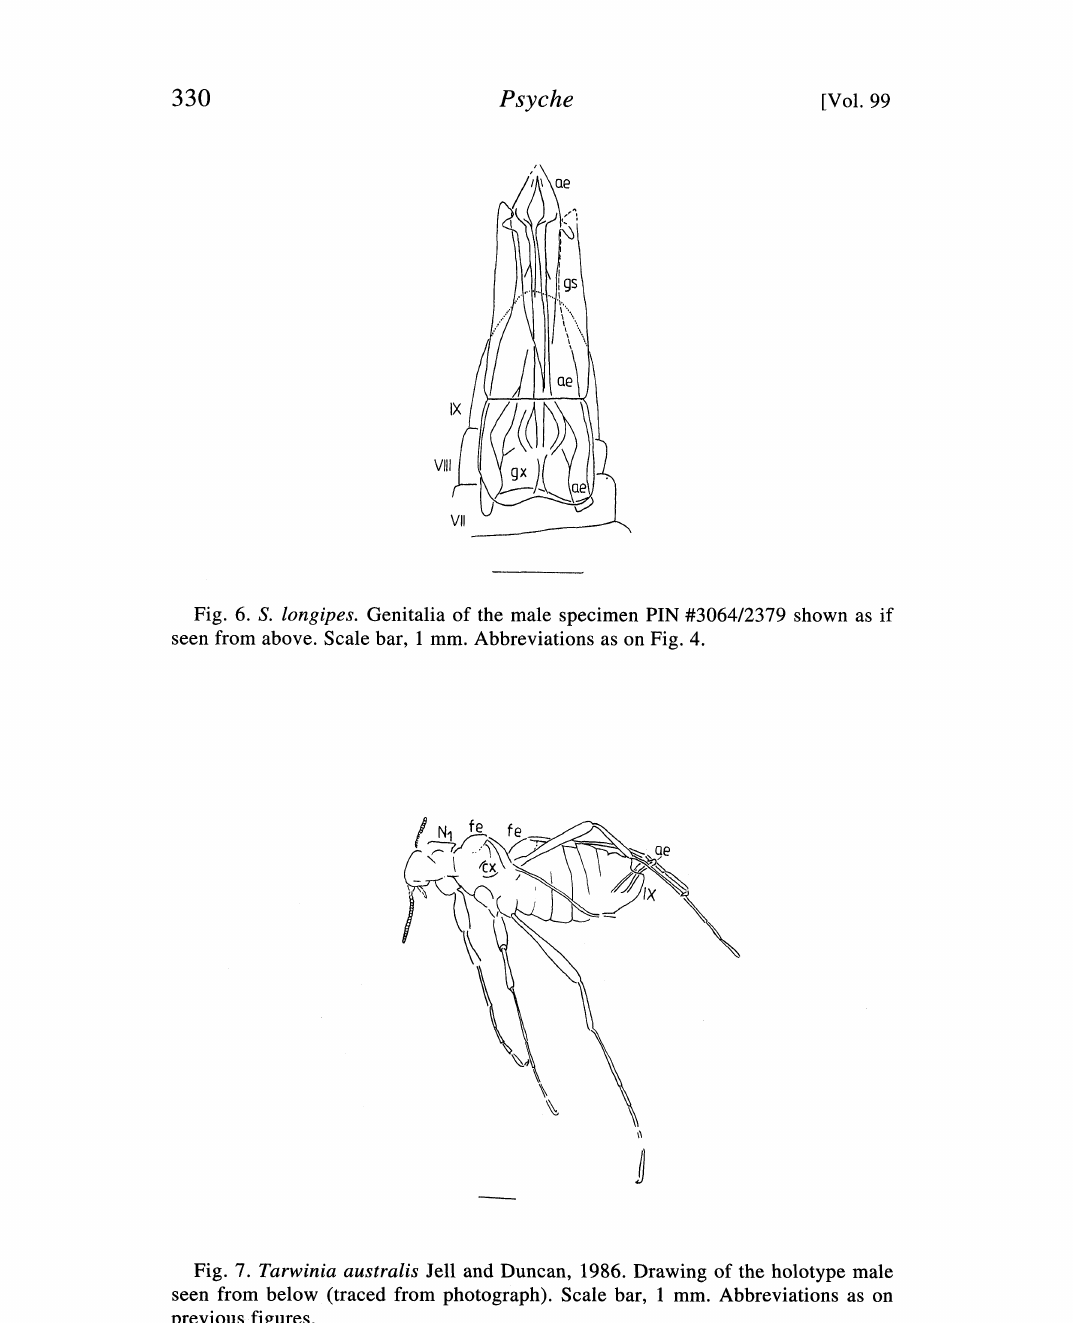
Fig. 7. Tarwinia australis Jell and Duncan, 1986. Drawing of the holotype male seen from below (traced from photograph). Scale bar, mm. Abbreviations as on previous